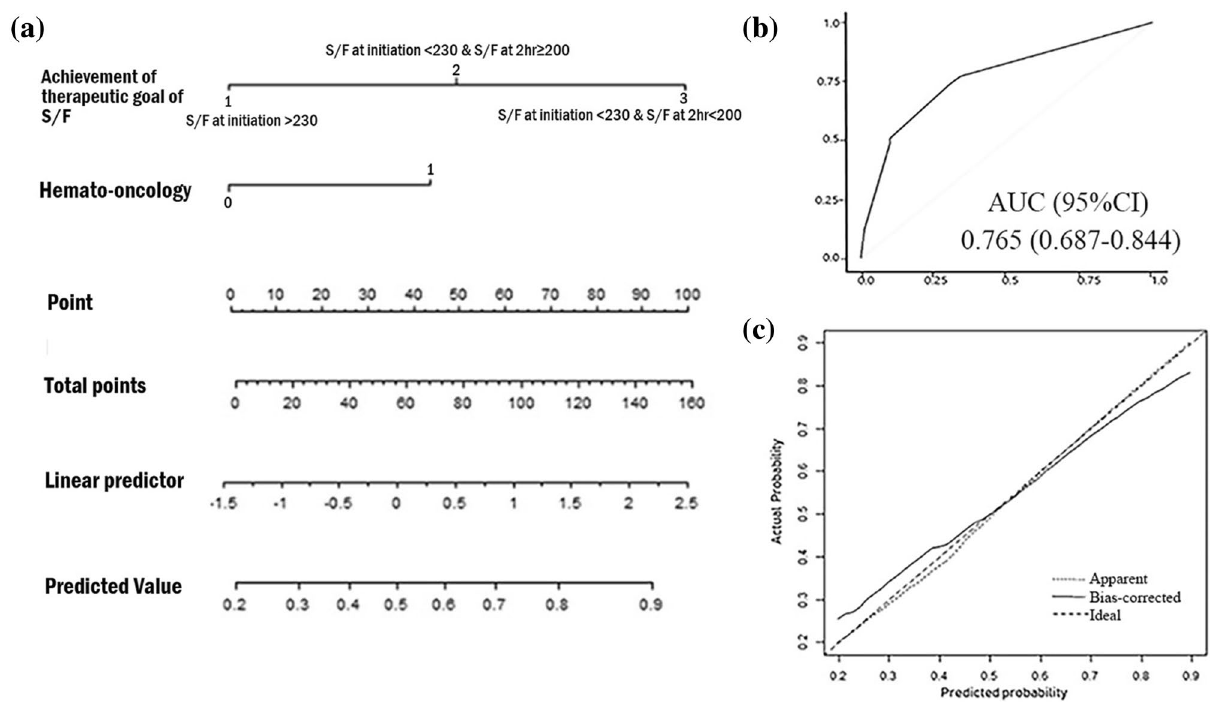
Figure 2. Constructed nomogram and performance of the model in the training cohort for predicting HFNC outcomes. ( a ) Nomogram according to clinical indices for predicting HFNC outcomes. The nomogram is used by adding up points identified on the points scale for each variable. The points of the three predictors should be added to calculate the total points. The straight edge should be aligned to the “total points,” and the predicted value would be visible on the last line. ( b ) ROC curve of the nomogram in predicting HFNC failure in the training cohort. AUC shows the ability of the nomogram. ( c ) Calibration curve of nomogram in the training cohort. The x-axis is the predicted probability from the nomogram, and the y-axis is the actual probability. The dashed line represents performance of the ideal nomogram (predicted outcome perfectly corresponds with actual outcome). The dotted line represents the apparent accuracy of our nomogram without correction. The solid line represents bootstrap-corrected performance of our nomogram. AUC, area under the ROC curve; ROC, receiver operating characteristic; HFNC, high flow nasal